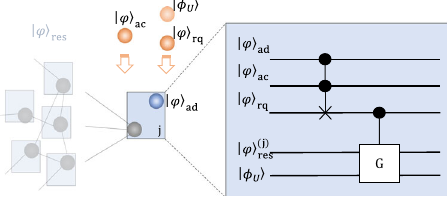
Fig. 6 Controlled addressing. Each device of the network possesses , as well as the resource and an addressing register prepared in φ j i ad auxiliary qubits (gray vertices). Note that each device owns some number of resource and auxiliary qubits, but we represent all of them uni fi ed in one for simplicity. Additionally, each device is , a program register ϕ U j i and provided with a request register φ j i rq . A Toffoli gate is applied, such that only if an activation register φ j i ac the addressing and activation registers match, the device is effectively turned on, and the control of the operations is now de fi ned by the request register state. A programmable operation G (Eq. (18)) is applied, controlled by the request register, resulting in the coherent application of some unitary U on the device ’ s resource qubits φ j i ð j Þ res